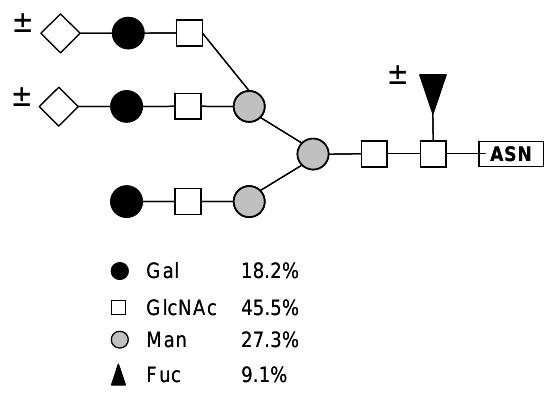
Figure 6. Structure of the oligosaccharide from porcine thyroglobulin (Figure 5, Fraction 3), which has the highest affinity to the lectin from tepary beans. This structure was proposed based on the monosaccharide composition of this fraction, shown in Table 8.